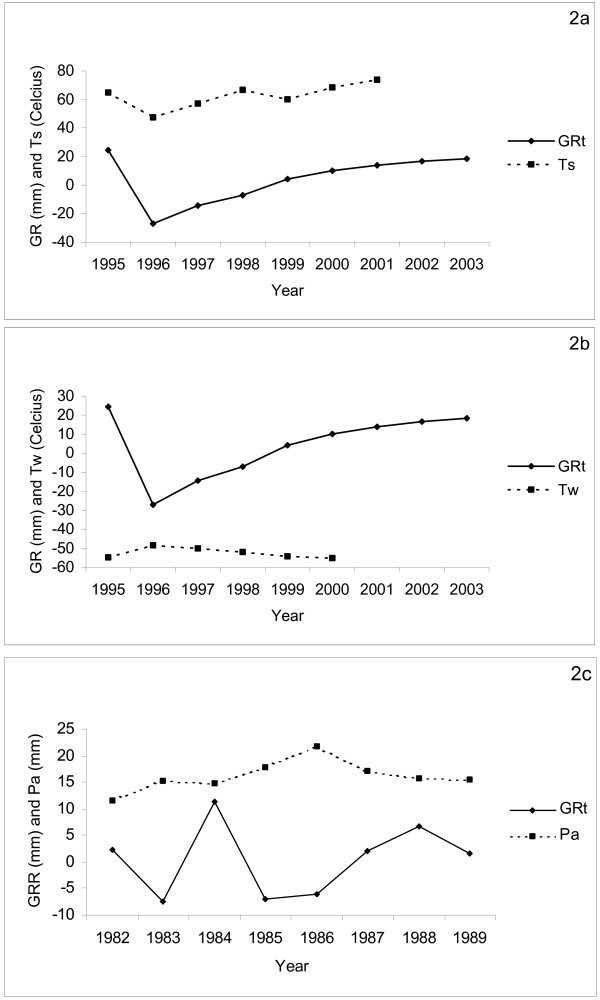
Growth rates obtained from otoliths of Arctic charr caught in Kangarssuk 2004 and 1990 plotted against fluctuations in mean annual temperature and precipitation. (a) Data from 2004 showing GRt (GRt = Growth rate residuals) in Arctic charr from Kangarssuk plotted against fluctuations in Ts (Ts = Mean summer temperature) (b) and Tw multiplied by 5 (Tw = Mean winter temperature). (c) Data obtained from otoliths collected in 1990 showing GRt in Arctic charr from Kangarssuk plotted against fluctuations in Pa divided by 20 from Aasiaat (Pa = Mean summer temperature).